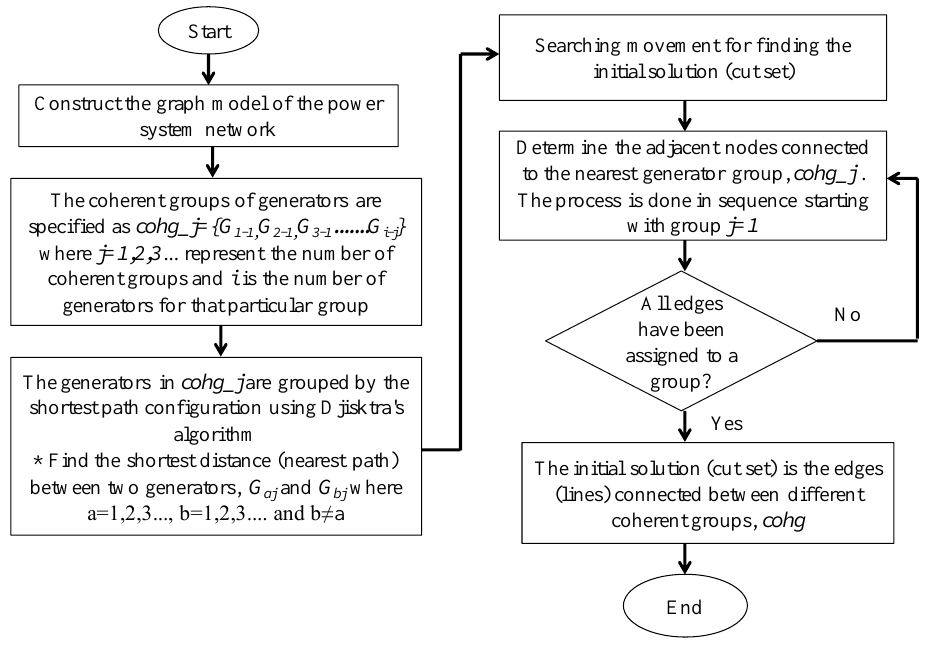
Figure 4. Initial cutsets using a heuristic approach.